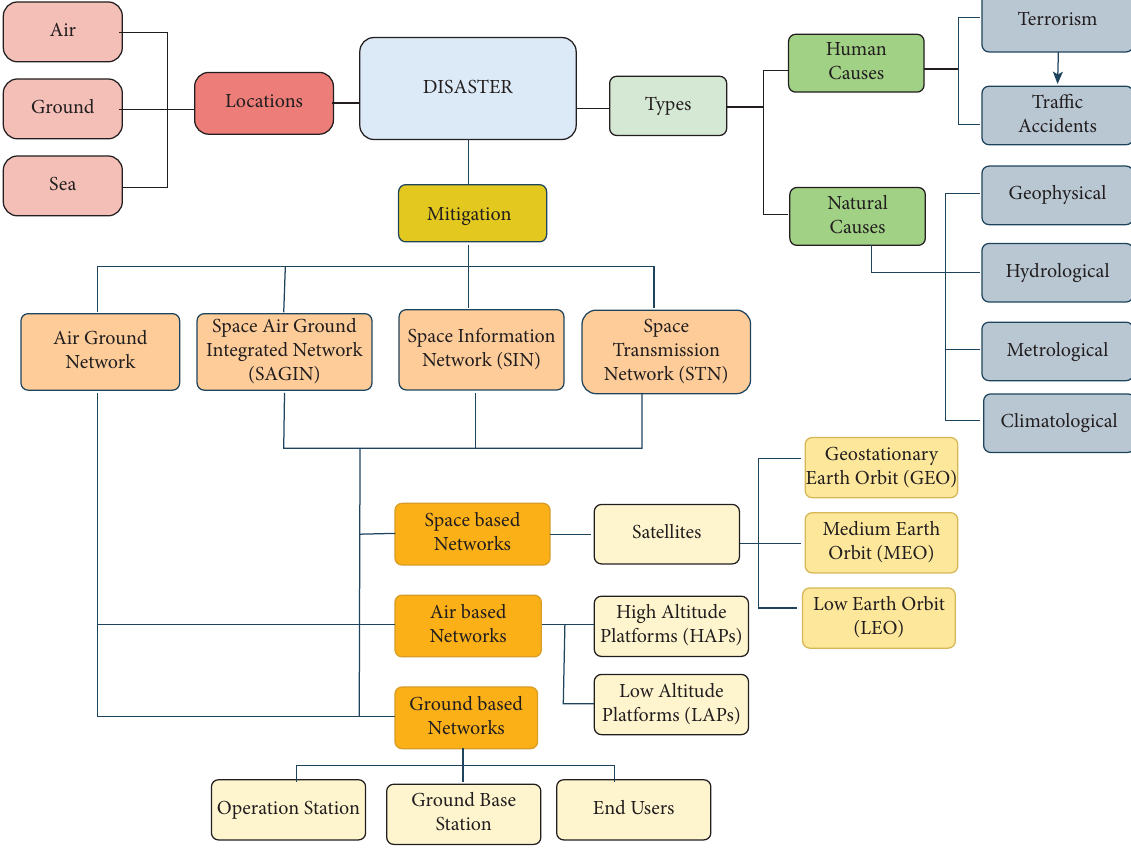
Figure 5: Devised taxonomy for disaster mitigation techniques.